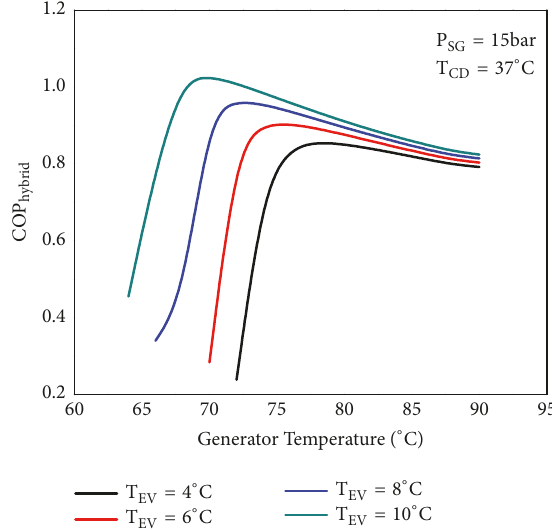
Figure 11: 𝐶𝑂𝑃 ℎ𝑦𝑏𝑟𝑖𝑑 vs . 𝑇 𝐺 for varying evaporator temperature, 𝑇 𝐸𝑉